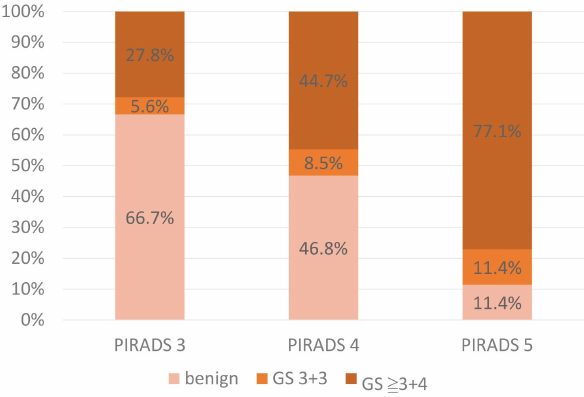
Fig. 4. Cancer detection rate stratified by PI-RADS